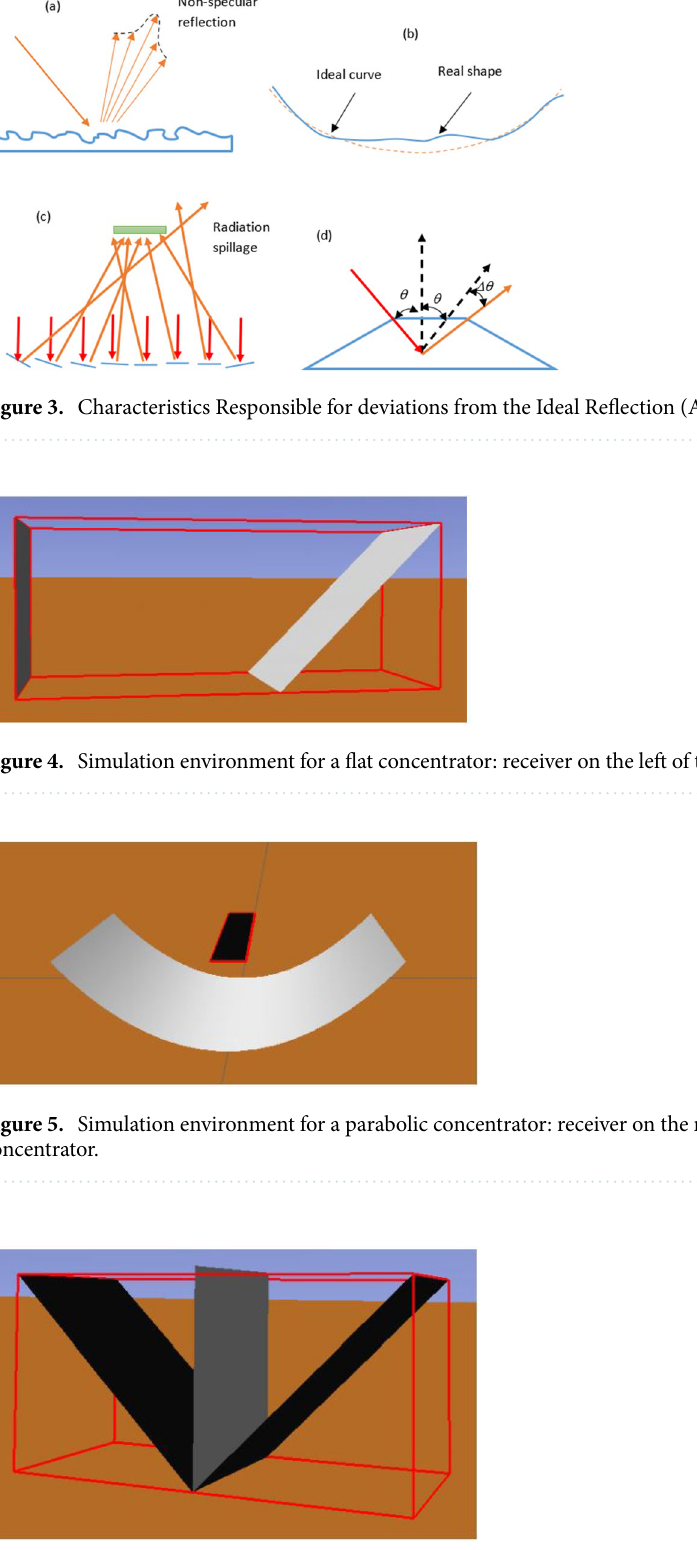
Figure 6. Simulation environment for a triangular concentrator: receiver between two flat concentrators (making a triangular